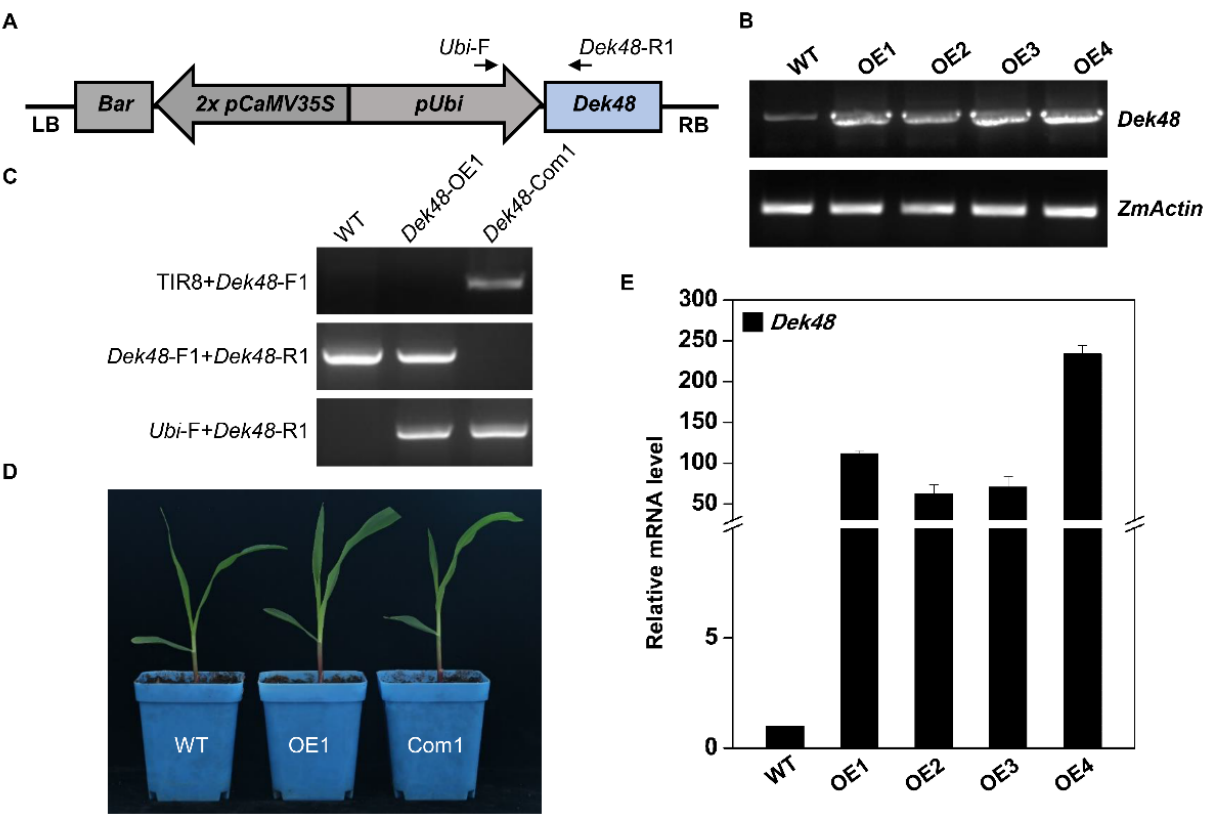
Figure 3. Over-expression of Dek48 causes the embryo-lethality of dek48 . ( A ) Transgenic construct of overexpression vector containing Dek48 . ( B ) Semi-quantitative RT-PCR analysis of Dek48 tran- scription profiling in WT and Dek48 overexpression plants. The expression levels were normalized to ZmActin ( GRMZM2G126010 ). ( C ) Genotyping of the overexpressed lines Dek48 -OE1 and the complemented lines Dek48 -Com1 harboring transgene Dek48 expression and Mu insertion in the endogenous Dek48 . ( D ) Seedling phenotype comparison among overexpressed lines Dek48 -OE1, com- plemented lines Dek48 -Com1, and wide type. ( E ) Quantitative RT-PCR analysis of Dek48 transcription profiling in WT and Dek48 overexpressed plants. The expression levels were normalized to ZmActin ( GRMZM2G126010 ). Data are means ( ± SE) of three biological replicates. 2.3. Embryo and Endosperm Development Are Arrested in